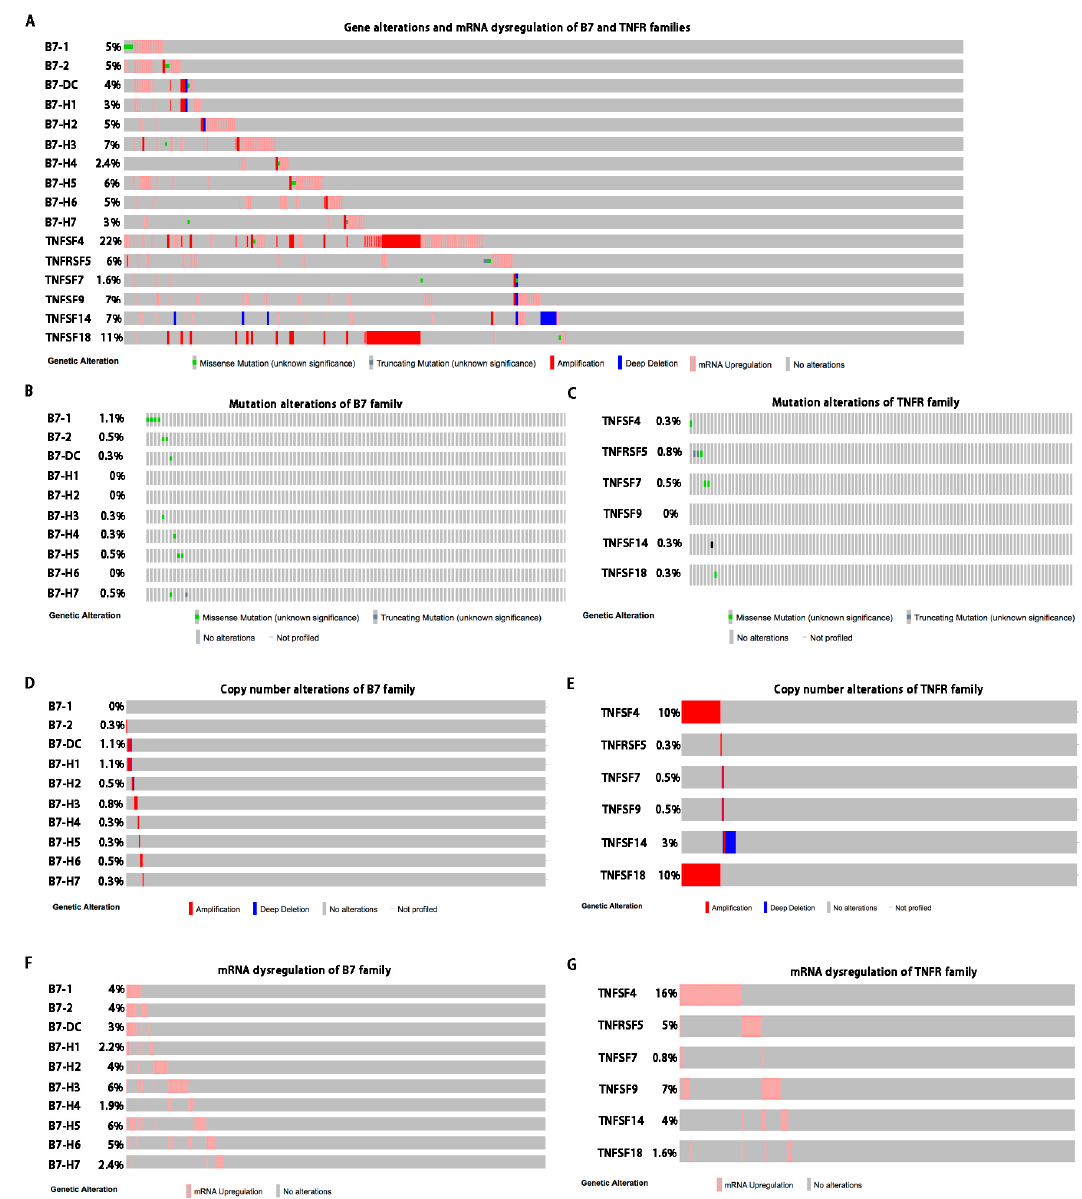
Figure 2. Gene alterations and mRNA dysregulations of B7 and TNFR family genes in HCC. ( A ) Gene alterations and mRNA dysregulations of B7 and TNFR family genes. ( B ) Mutation alterations of B7 family genes. ( C ) Mutation alterations of TNFR family genes. ( D ) Copy number alterations (CNA) of B7 family genes. ( E ) CNAs of TNFR family genes. ( F ) mRNA dysregulations of B7 family